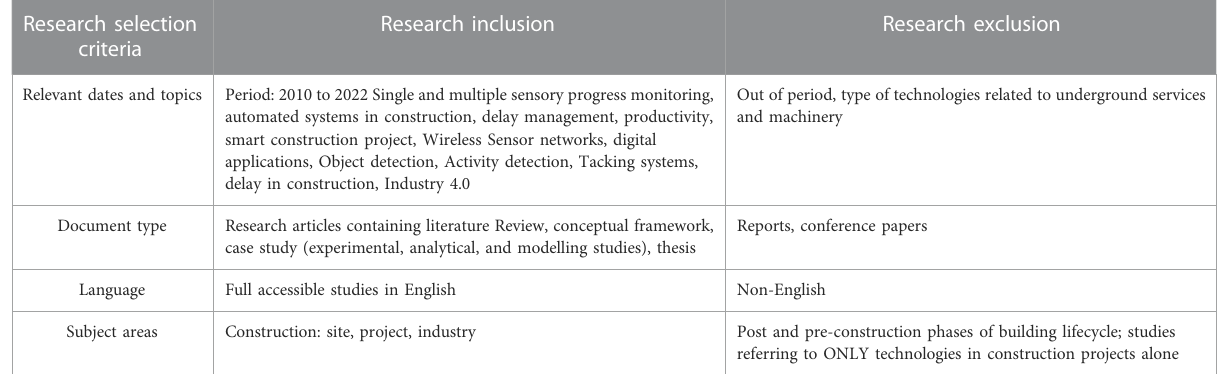
TABLE 2 Research selection criteria: Inclusion and exclusion. Research selection